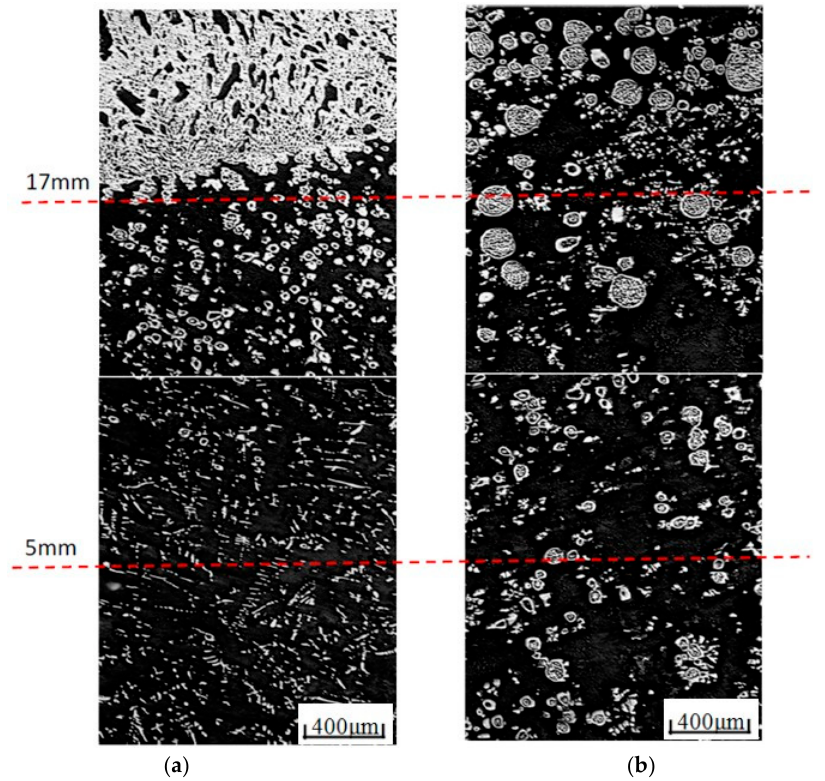
Figure 5. Solidified structure of Cu-55 at % Pb alloy, and the dotted line shows the distance from the bottom. ( a ) 0 T; and ( b ) 12 T.